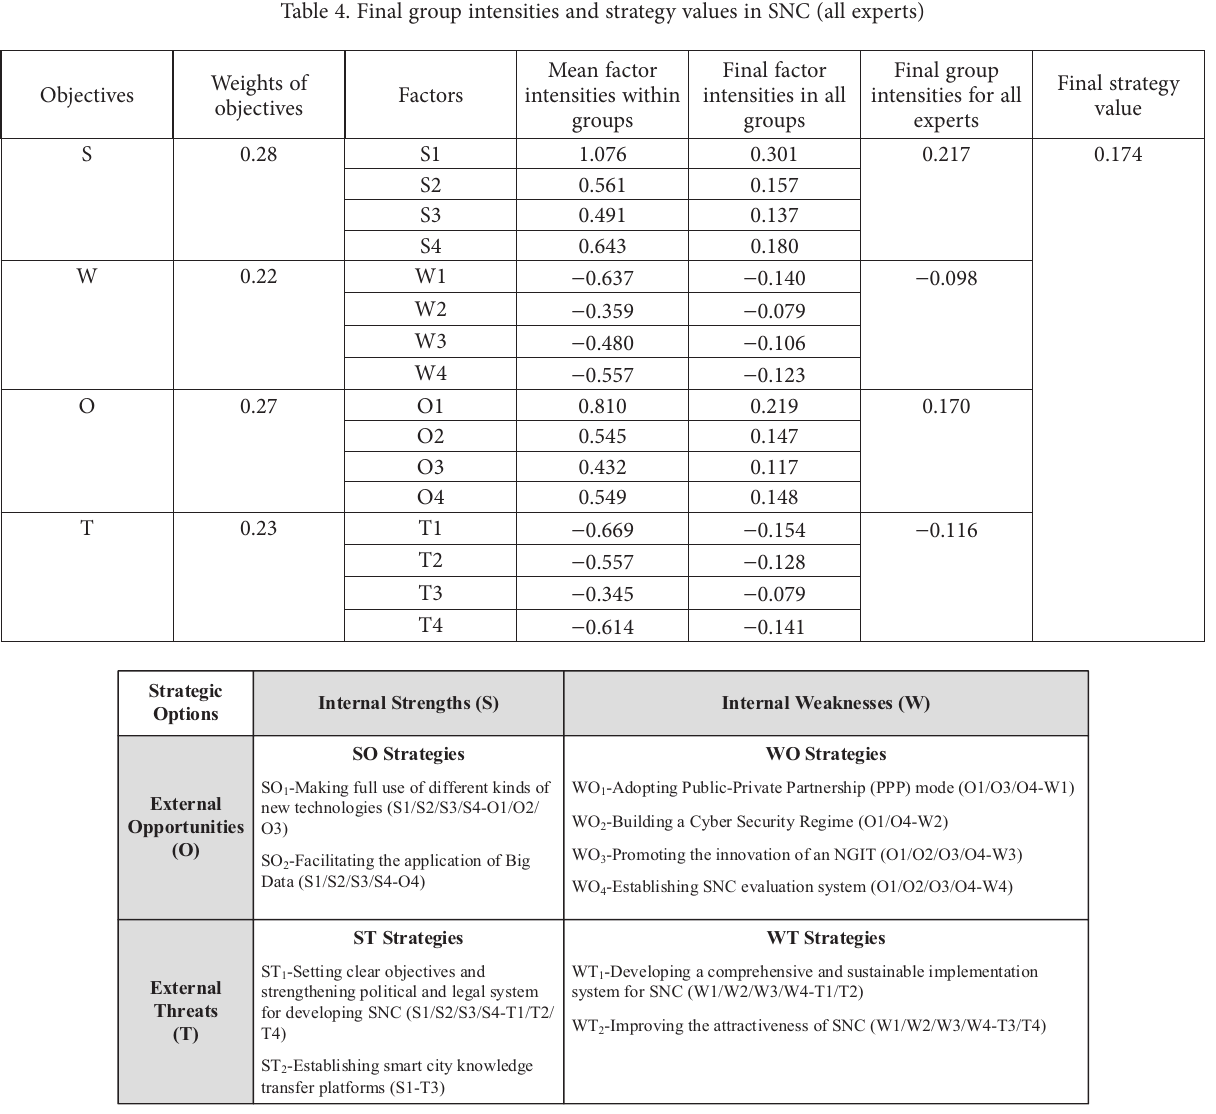
Figure 6. The intensities for different SWOT